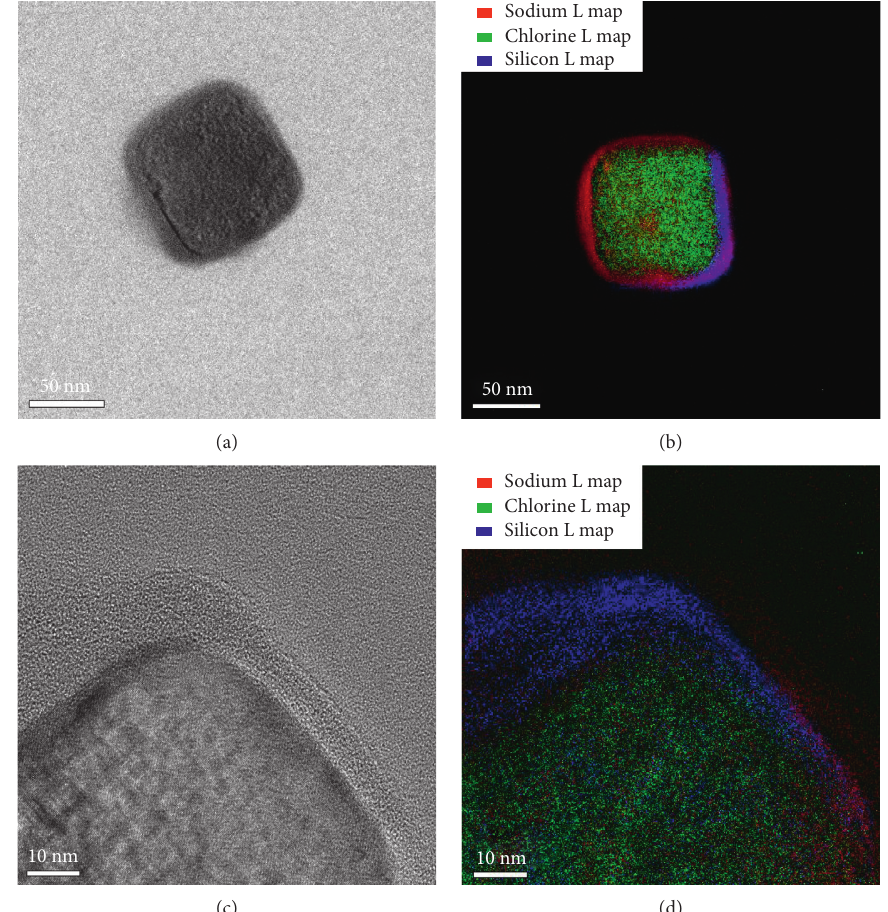
Figure 8: EFTEM-EELS high resolution images of NaCl-SiO of SiO 2 surrounding the NaCl